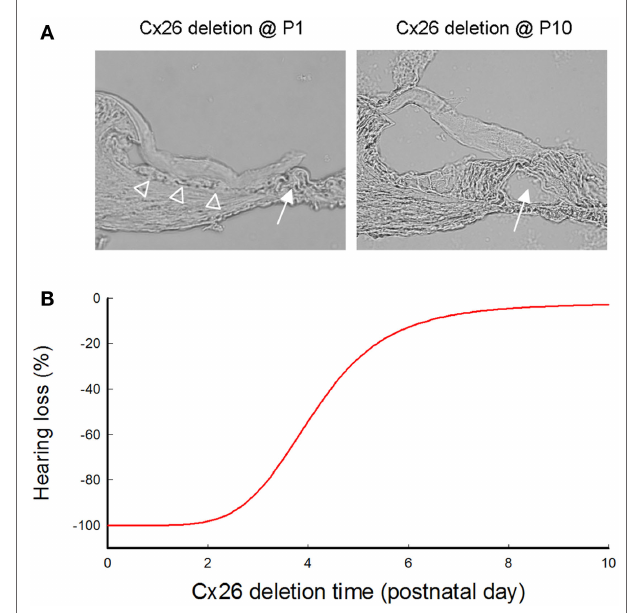
FiGuRe 3 | Cochlear developmental disorders and hearing loss induced by deletion of Cx26 in the cochlea at different postnatal times . (A) Cochlear development after deletion of Cx26 at P1 and P10. White arrows indicate that the cochlear tunnel is filled when Cx26 was deleted at P1 but developed normally when Cx26 was deleted at P10. Empty triangles indicate lack of the under-tectorial-membrane space; the tectorial membrane is attached to the inner sulcus cells following deletion of Cx26 at P1. (B) Hearing loss following deletion of Cx26 at different postnatal times. The ABR thresholds were measured at P30 and were normalized to that in WT mice. Corresponding to cochlear developmental disorders, deletion of Cx26 before P5 can induce severe hearing loss. However, hearing remains normal in young mice following deletion of Cx26 after P6. Modified from Chen et al. (2014).